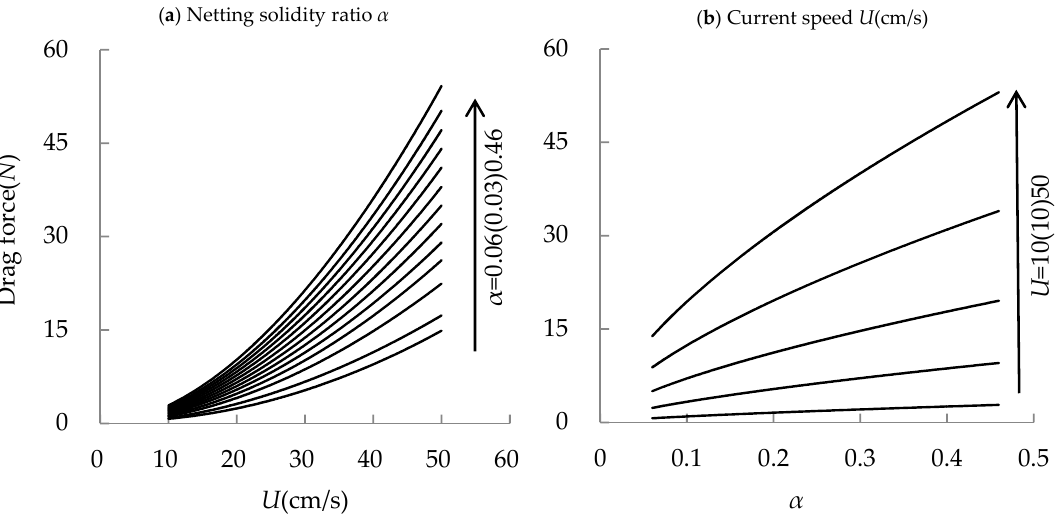
Figure 7. Relationship of drag force and mesh factor plotted against current speed. ( a ) the relationship of R D and U for each α ; ( b ) the relationship between R D and α for each U.